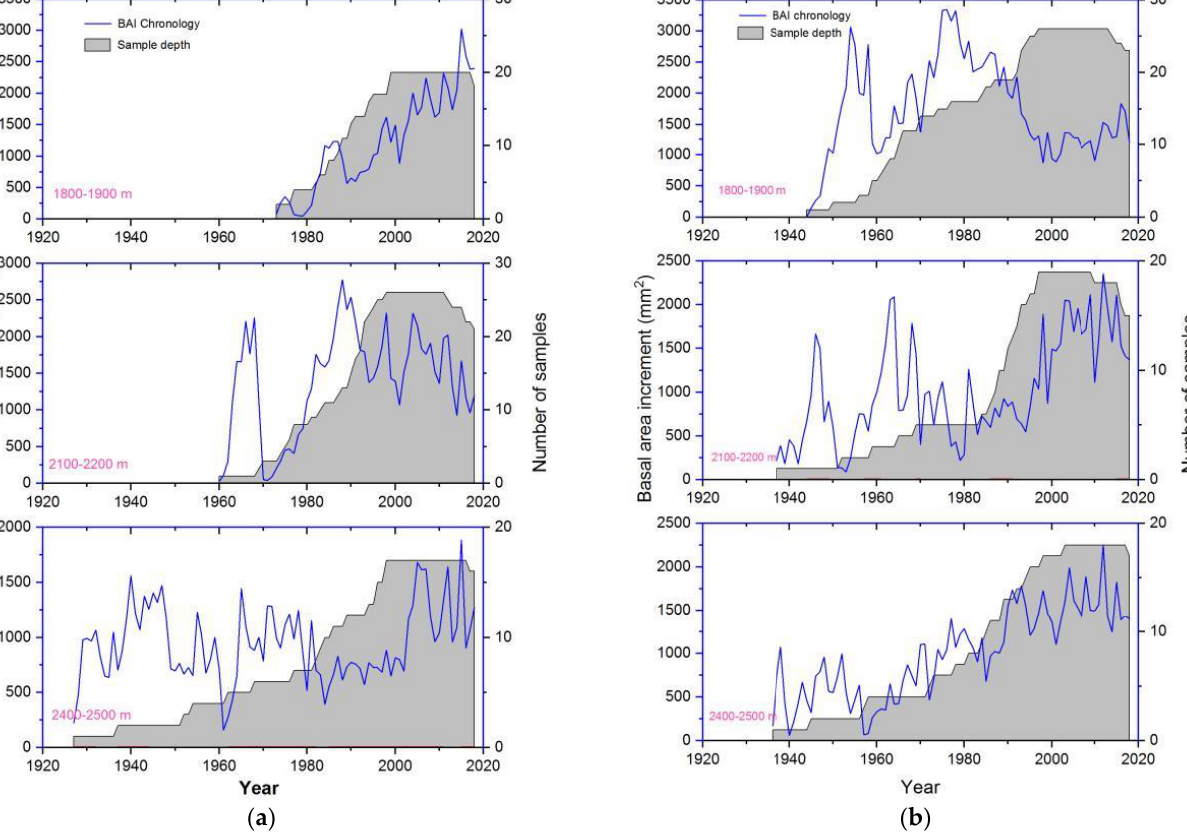
Figure 6. Basal area increment (BAI) chronologies (Blue line) of P. wallichiana with sample depth (shaded area) along the elevation gradient in the Makwanpur districts — lower elevation belt (1800 – 1900 masl), middle elevation belt (2100 – 2200 masl) and upper elevation belt (2400 – 2500 masl): ( a ) northeast aspect; ( b ) northwest aspect.